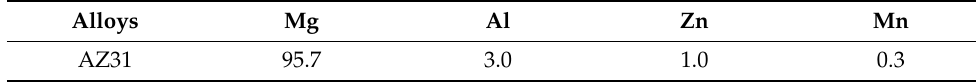
Table 1. Chemical composition of AZ31 Mg alloy.